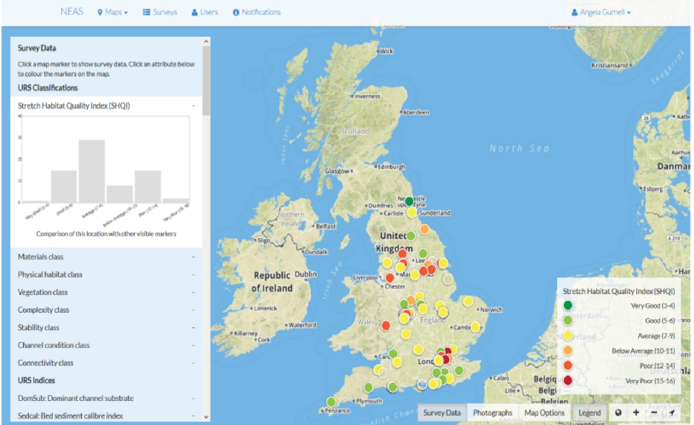
Figure 4. Screenshot from Cartographer showing SHQI values derived from River Surveys and dis- played in graphical and map-based